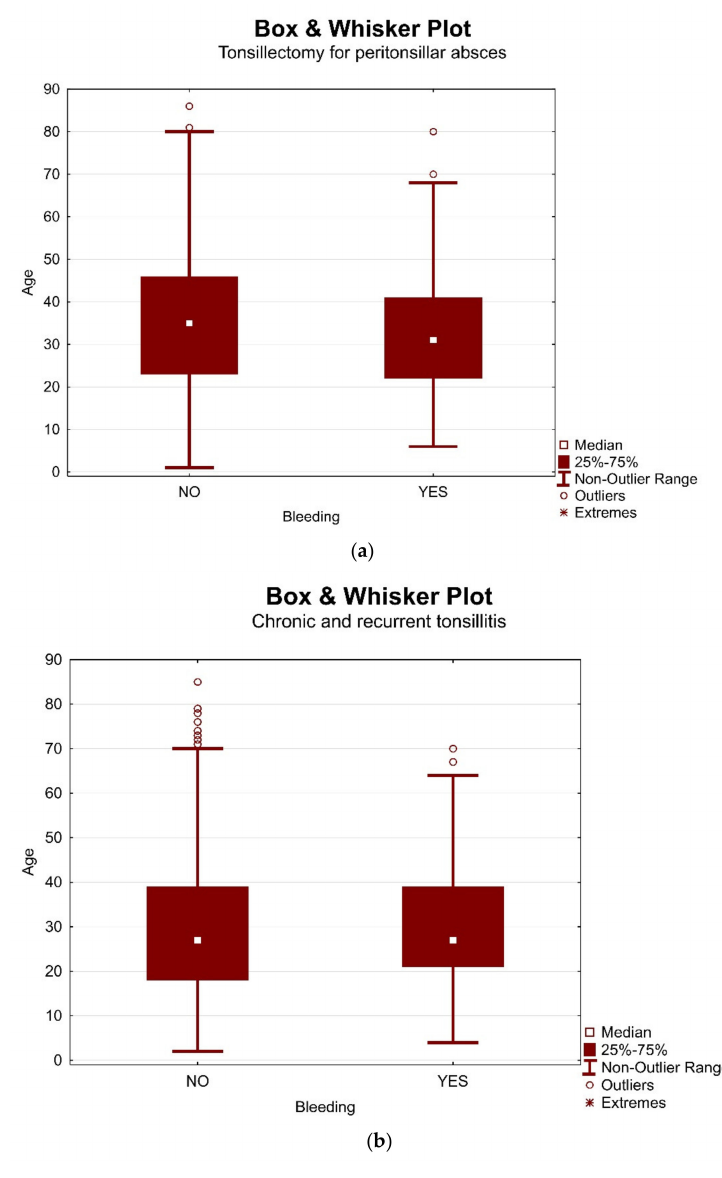
Figure 3. ( a ). Distribution of patients and bleeding depending on age in group I (peritonsillar abscess (PTA)). ( b ). Distribution of patients and bleeding depending on age in group II (chronic tonsillitis (CHT) + recurrent tonsillitis